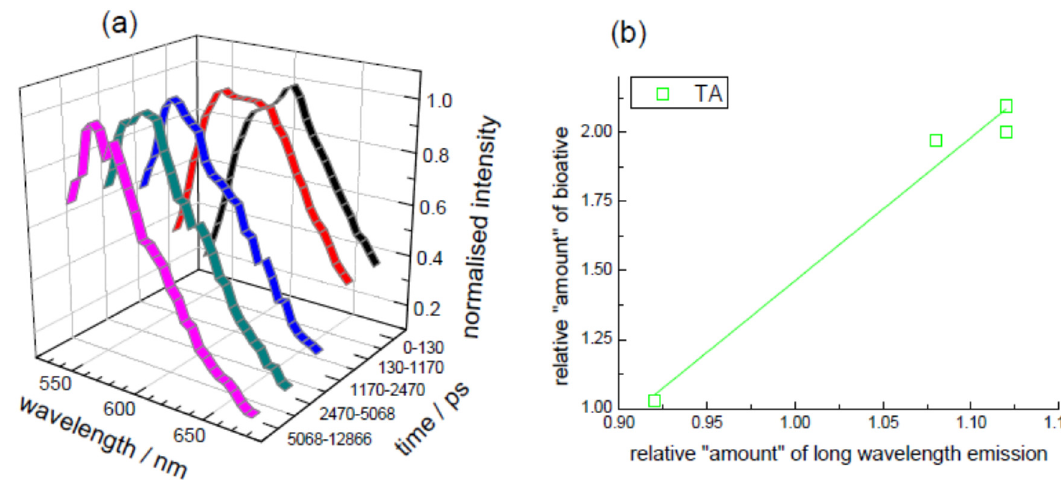
Figure 11. ( a ) TRES “time slices” measured from a sample of baked potato. The intensities are shown normalised. Excitation was at 510 nm (DD-510L); ( b ) Comparison of longer wavelength emission [46] with relative (to uncooked) quantity of TA. Adapted from